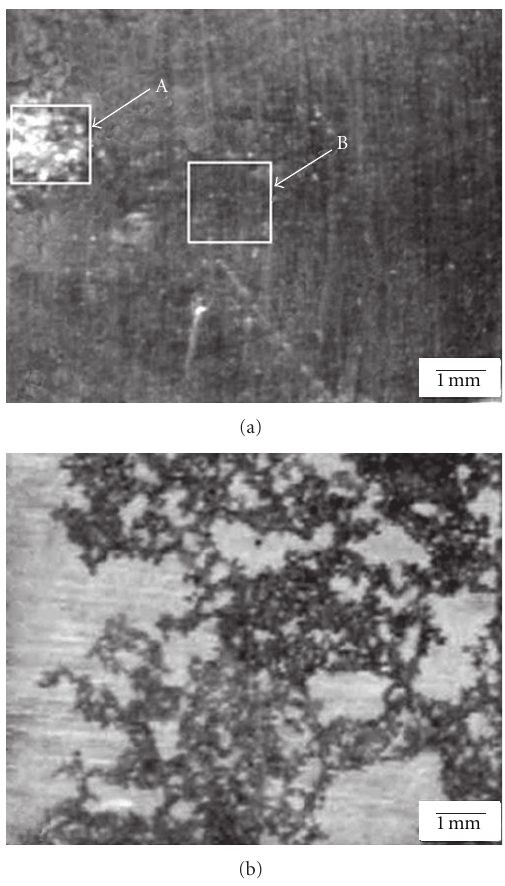
Figure 4: Optical observation of pitting for (a) AZ91D and (b) ZA10403 after 8 h of immersion in untreated 5% NaCl solution saturated with Mg(OH) 2 at pH 9 and 25 ◦